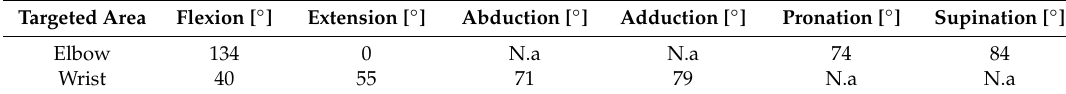
Table 2. Motion ranges for the elbow and wrist rehabilitation.